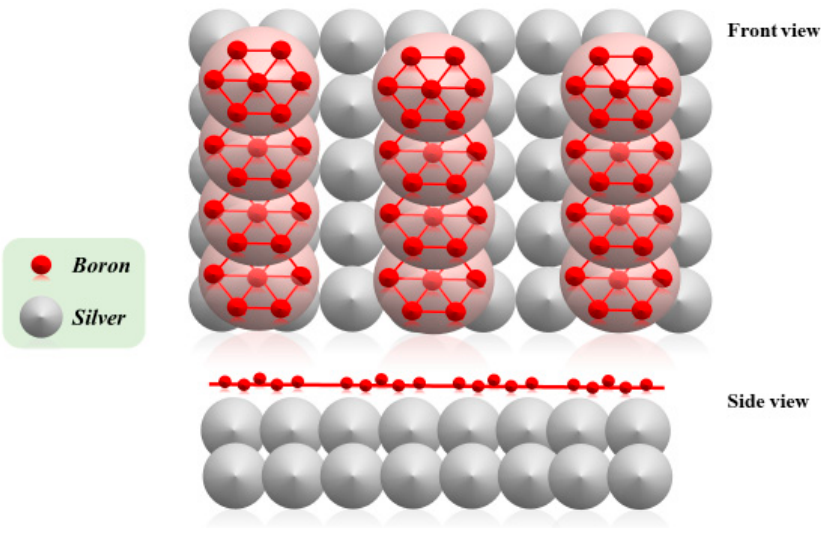
Figure 1. Atomic geometry of borophene on Ag(111), in front ( top ) and side ( bottom ) views.